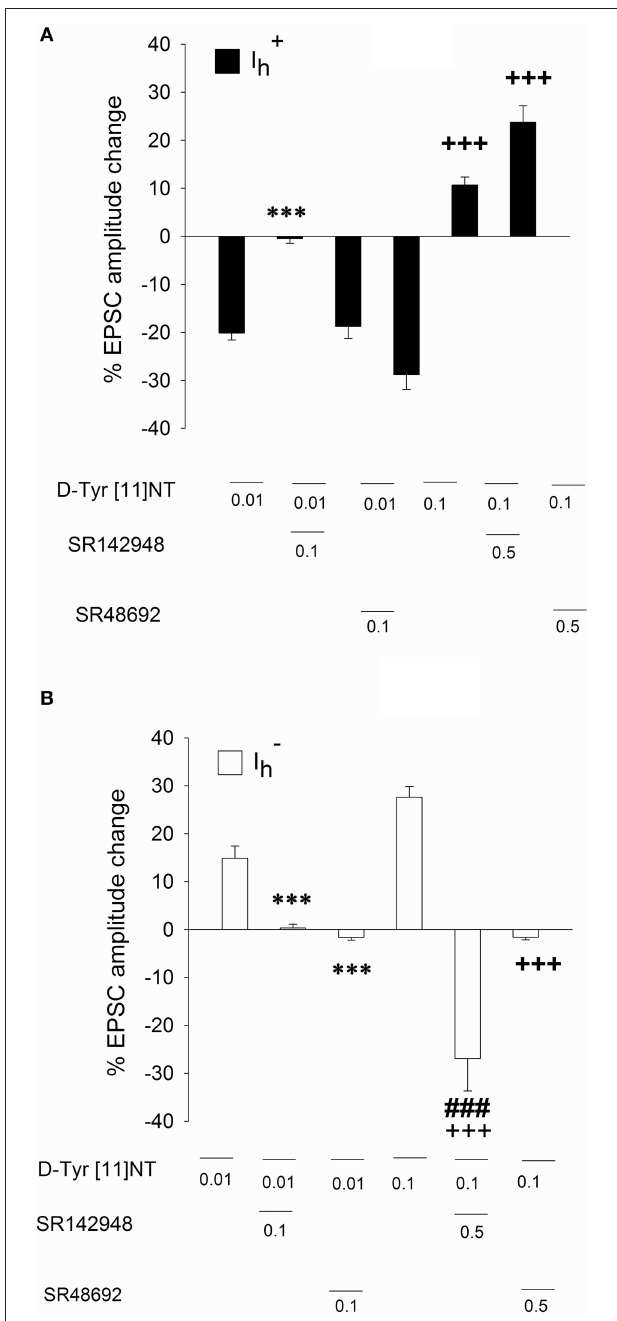
FIGURE 7 | Effect of SR142948 and SR48692 on glutamatergic EPSCs in I + h and I − h neurons. Mean percent change in EPSC amplitude recorded in I + h (A) and I − h neurons (B) following application of [D-Tyr 11 ]NT alone or in the presence of SR142948 or SR48692. The number of neurons recorded